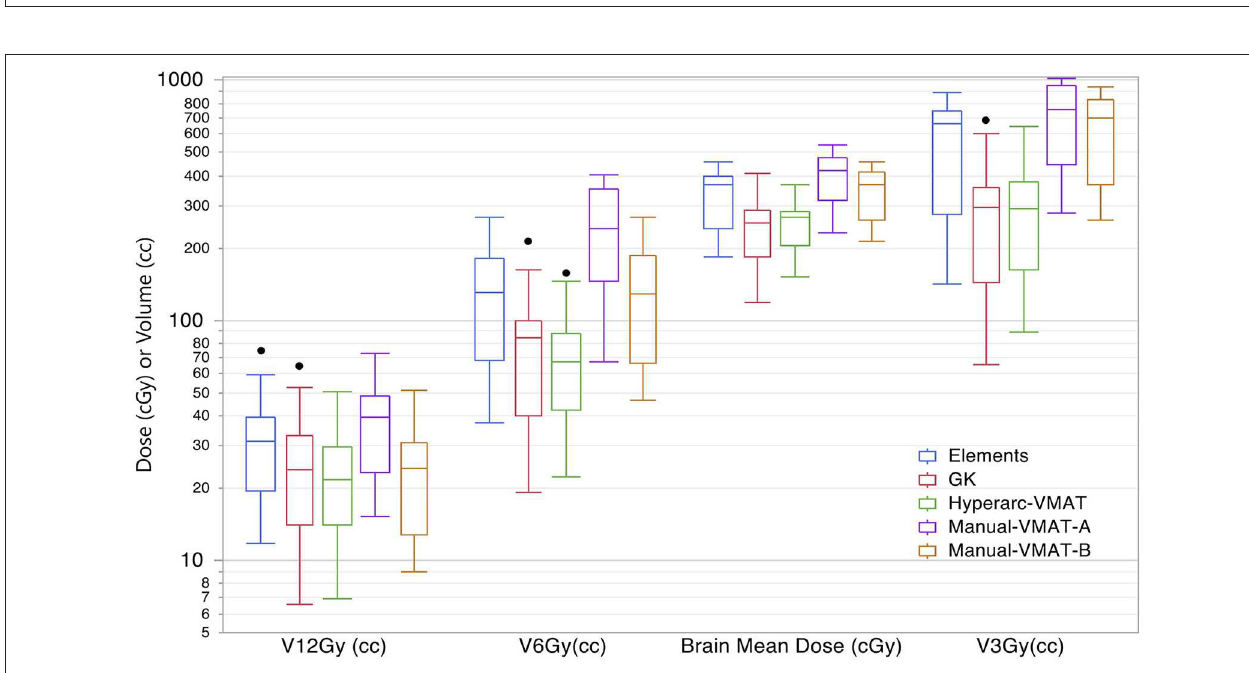
FIGURE 3 | Box plot results per SRS plan type for the following dosimetric parameters across all patients: the total volume of brain receiving 12Gy, 6Gy, and 3Gy (V 12Gy , V 6Gy , V 3Gy ) and the mean dose to the brain excluding the targets (Brain mean dose).